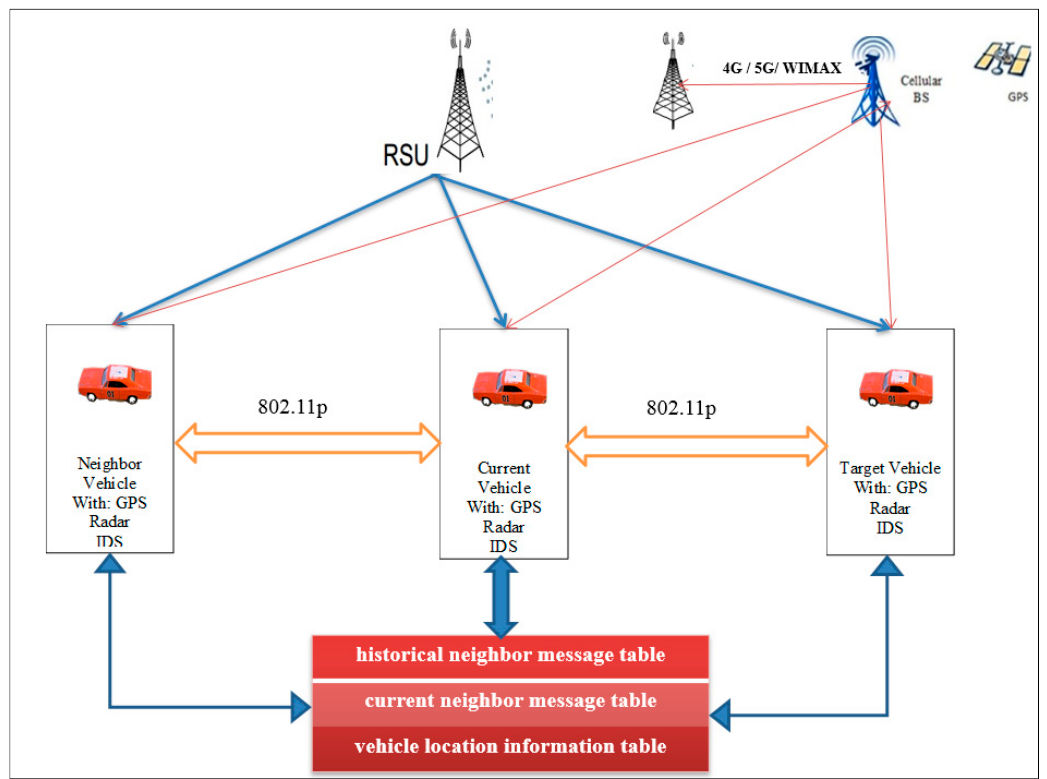
Figure 1. Vehicle ad hoc network model.